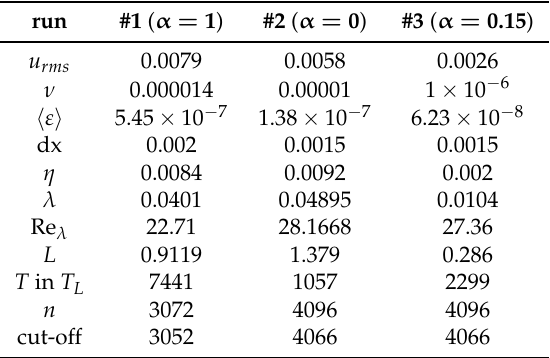
(cid:28)(cid:16) (cid:17) 2 (cid:29) ∂ u , grid spacing dx, ∂ x (cid:113) ν , Taylor-Reynolds number Re λ = u rms λ , (cid:104) ε (cid:105) ν , number of grid points N and u rms